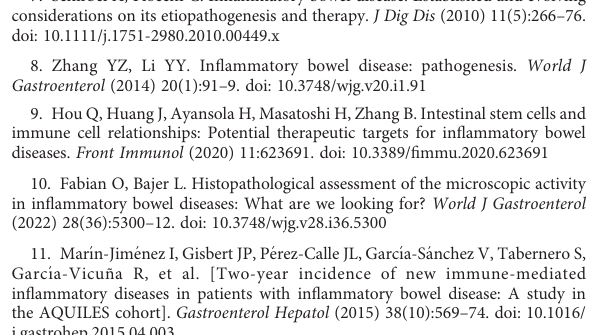
SUPPLEMENTARY TABLE 1 Metalloproteinase-related genes. SUPPLEMENTARY TABLE 2 Scoring criteria for the histological examination of